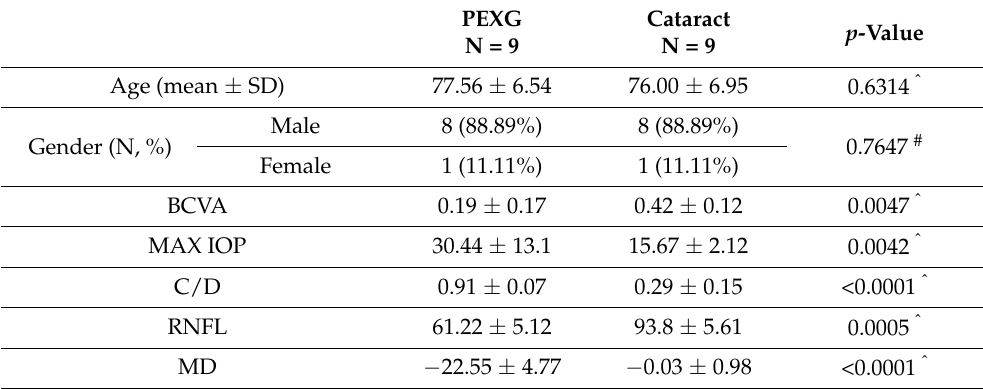
Table 1. Demographic and clinical characteristics of the study